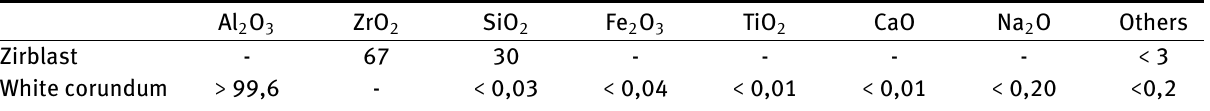
Table 2: Chemical composition of abrasive in wt. %. Al 2 O 3